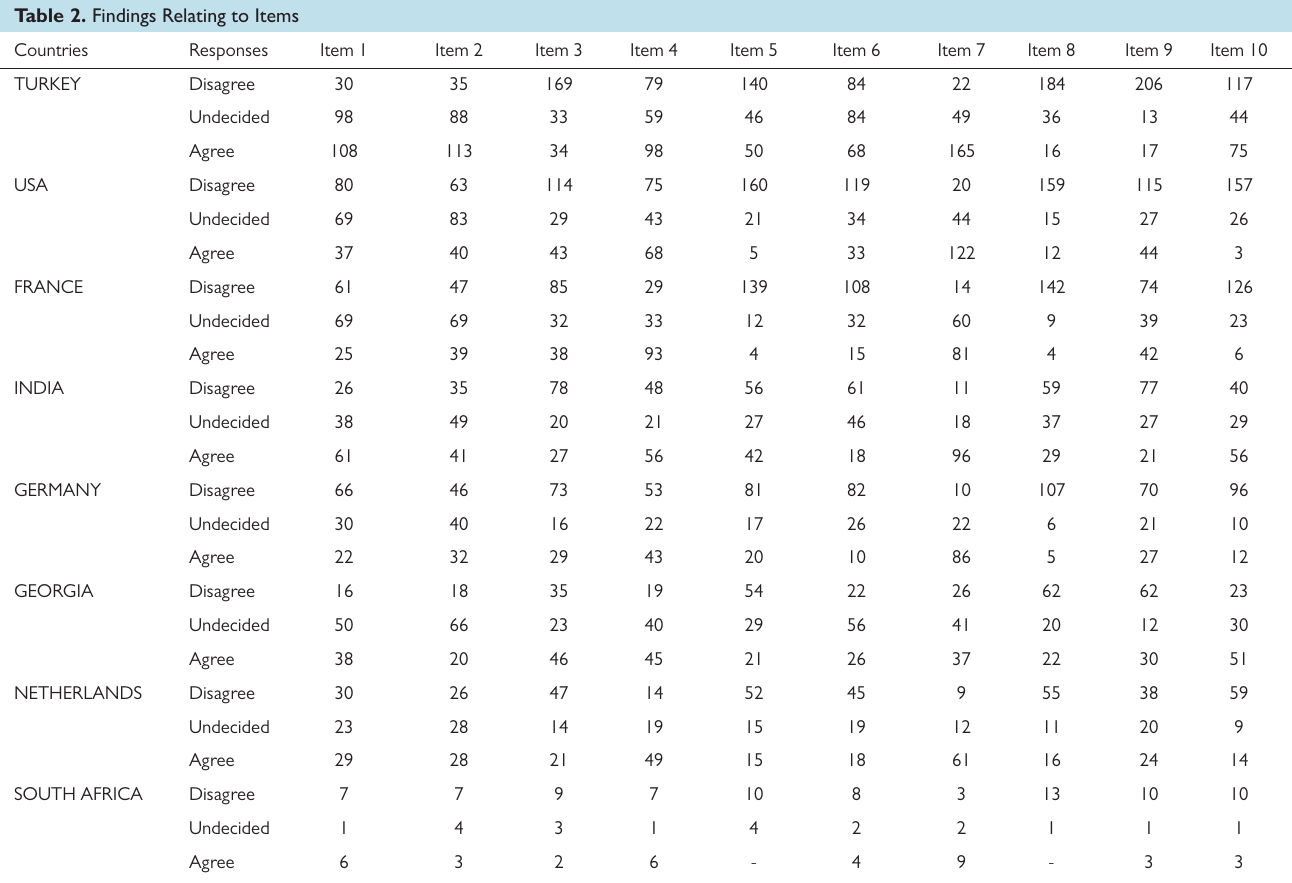
Table 2. Findings Relating to Items Countries